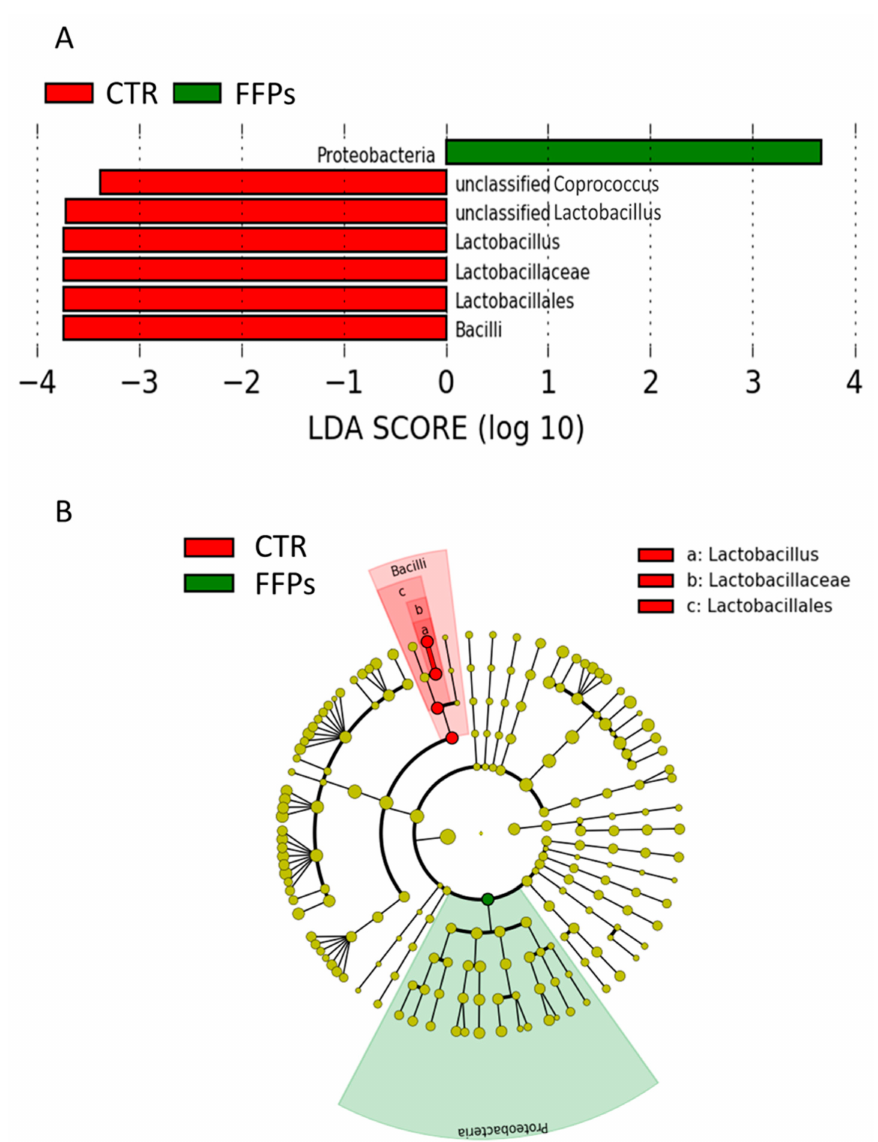
Figure 5. ( A ) Plot from LefSe analysis indicating enriched bacterial taxa associated with post weaning piglets fed with the FFP (green) or CTR (red) diet; ( B ) Di ff erent representation of LefSe analysis in the form of cladogram, which is one way of representing significance and phylogeny. The red and green colors represent the branch of the phylogenetic tree that most significantly represents the CTR and FFP groups,